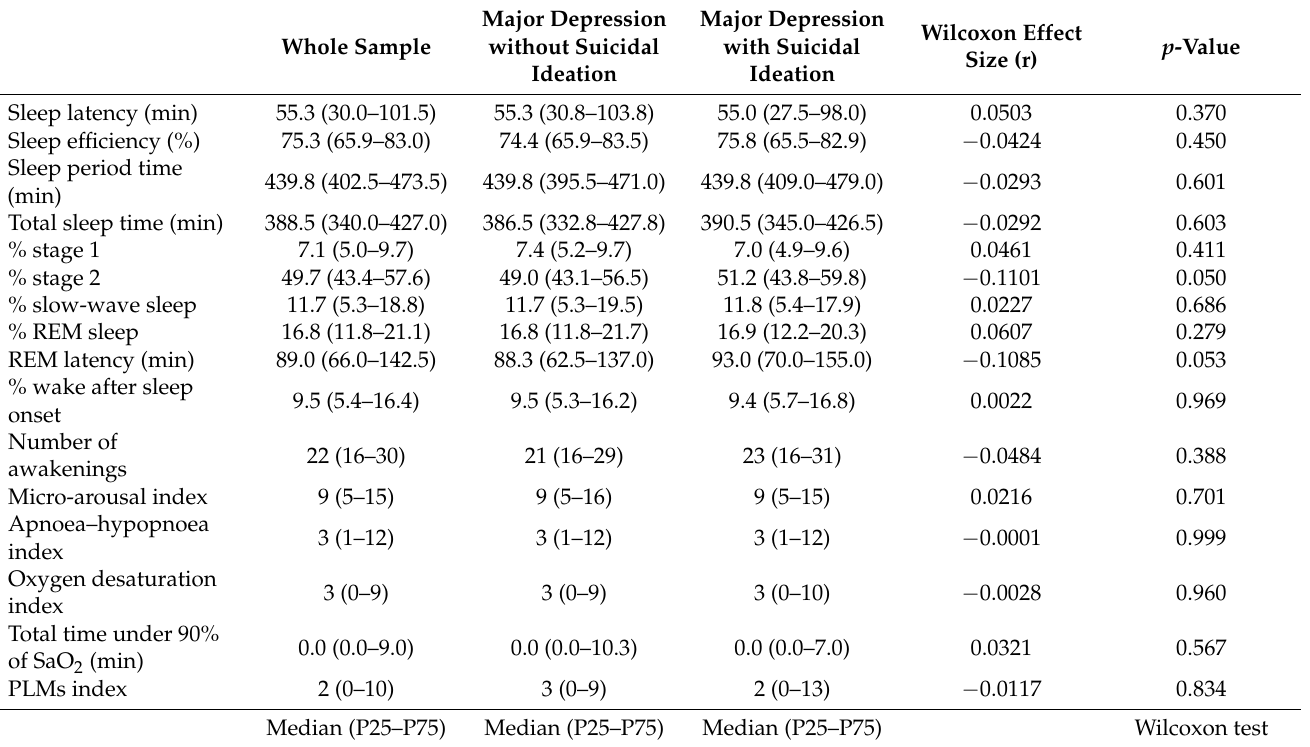
Table 4. Polysomnographic data ( n =